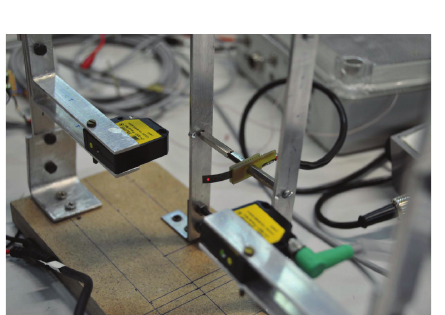
Figure 1: IPMC structure.